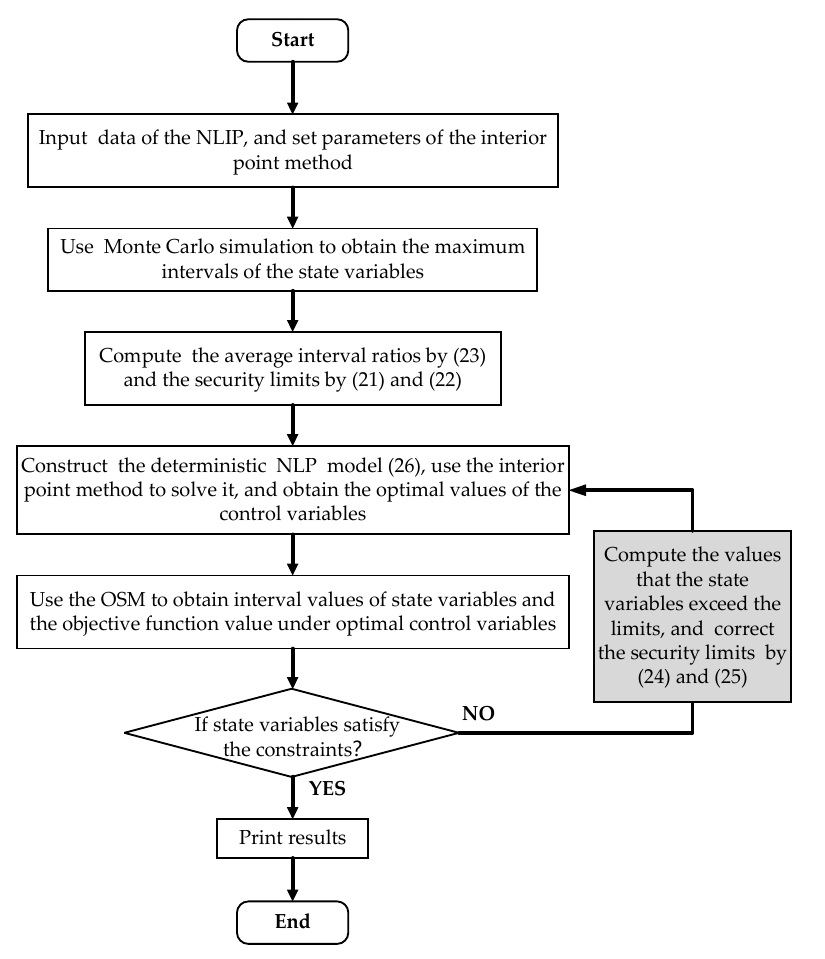
Figure 3. The procedure of the MSLM for solving the NLIP.